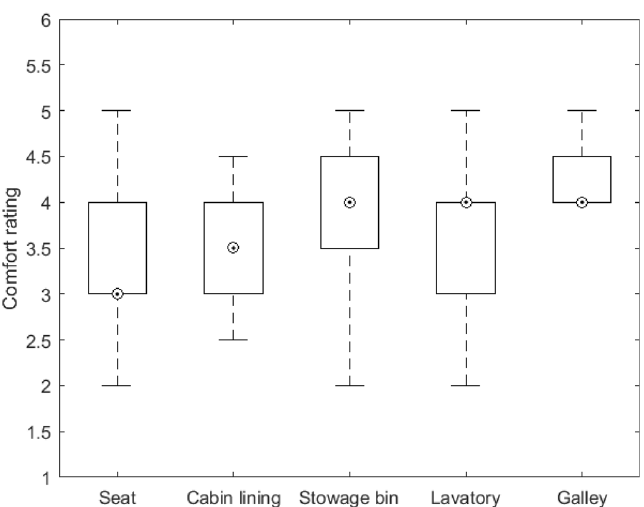
Figure 9. Box plots showing the distribution of participants’ median comfort scores for each environment. On each box, the square within the circle indicates the median, and the bottom and top edges of the box indicate the 25th and 75th percentiles,